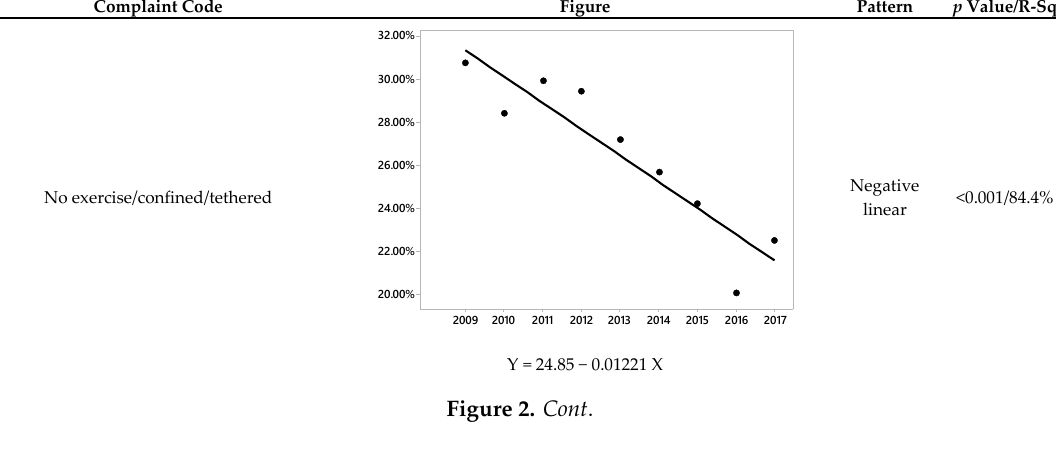
Y = 24.85 − 0.01221 X Figure 2. Cont